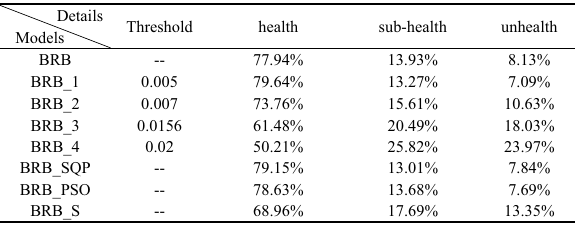
Table 7. Average belief degrees distribution of different BRBs.